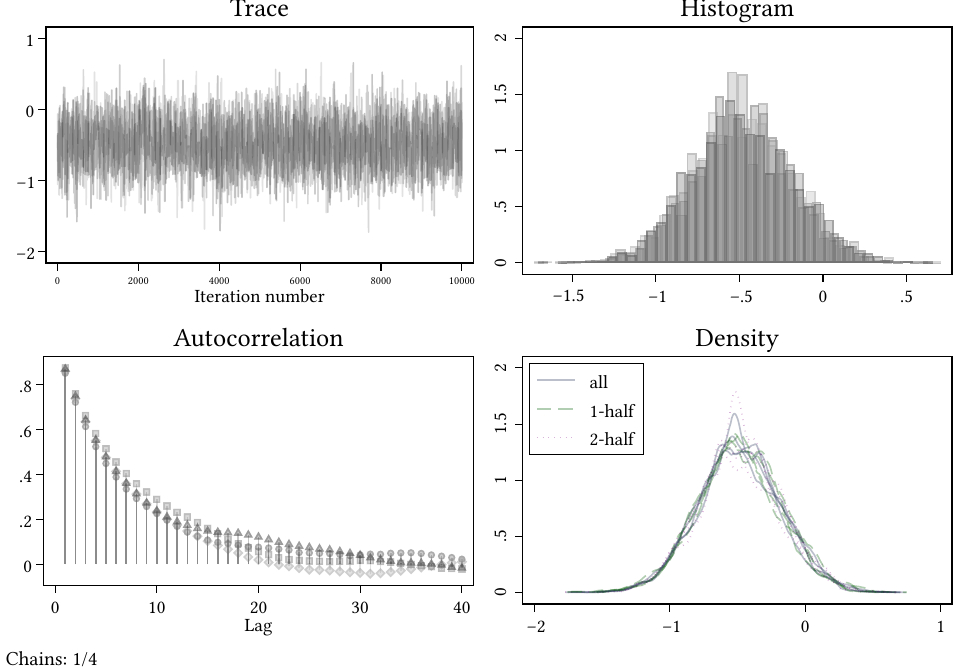
Figure A6. How awareness of the lowest asks influences the response to extreme asks. The Low Info